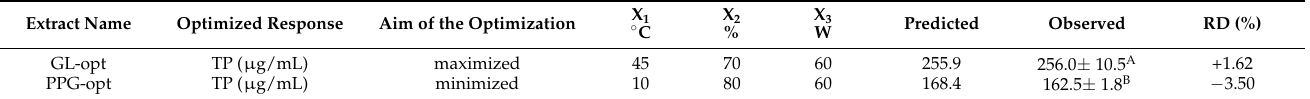
Table 5. Predicted and observed responses values for the extracts prepared at optimal conditions.